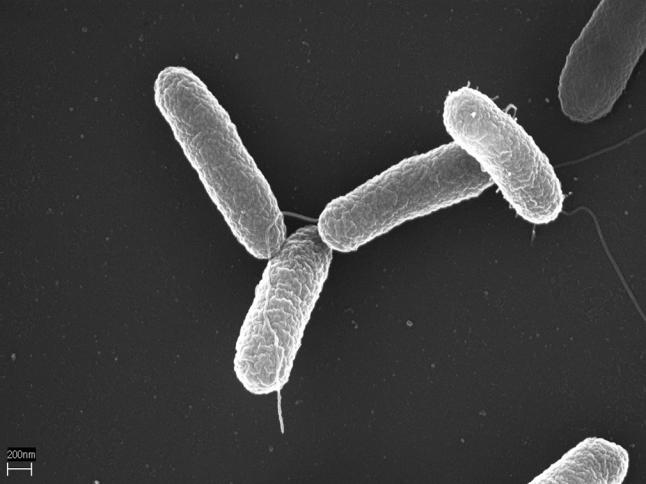
Many predicted genes were tied to food poisoning and bacterial pathogens, such as Salmonella typhimurium (Photo: Volker Brinkmann, Max Planck Institute for Infection Biology, Berlin, Germany)